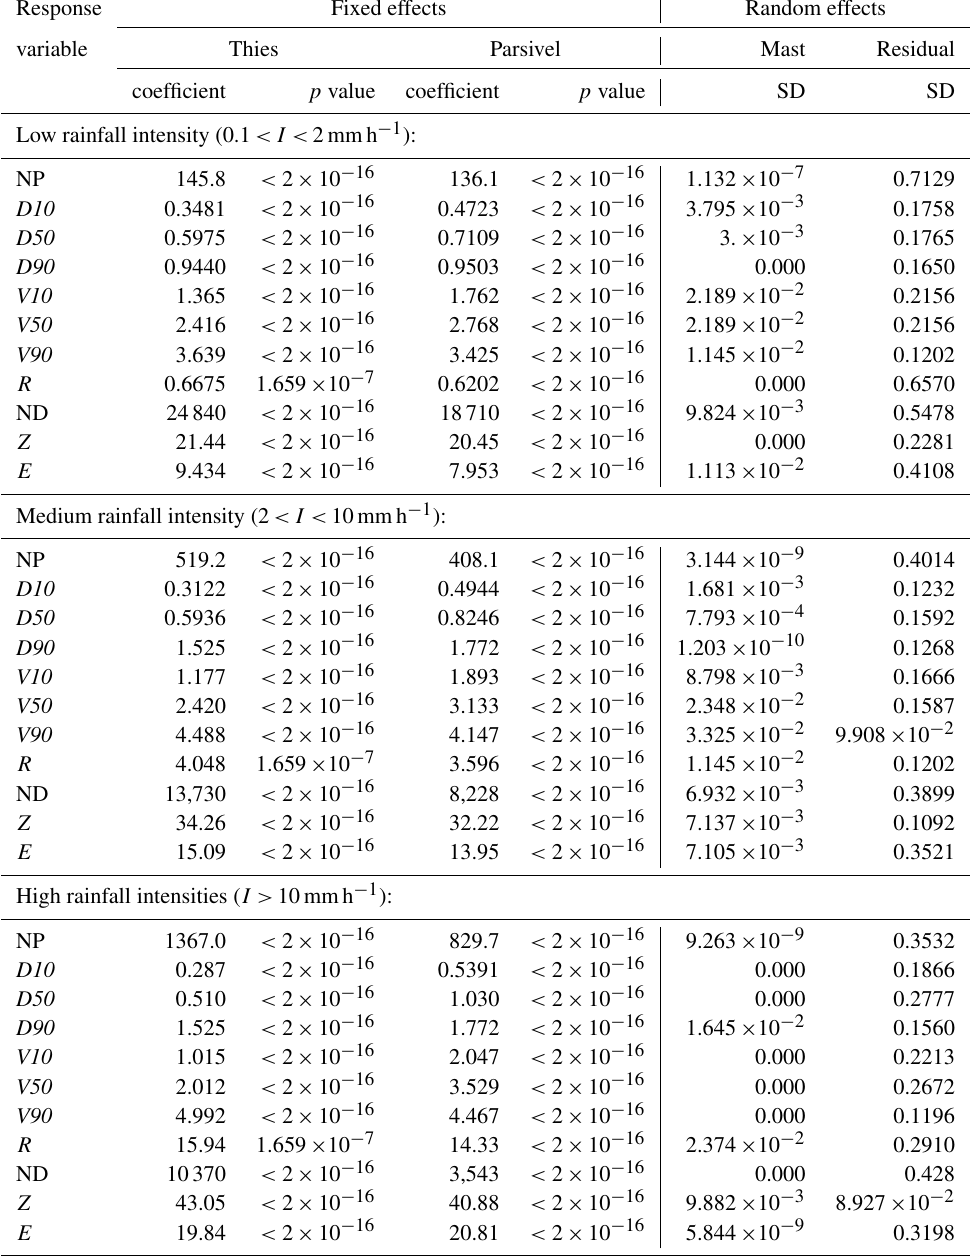
Table 6. Gamma generalized linear mixed-effects model coefficients for minutes with varying rainfall